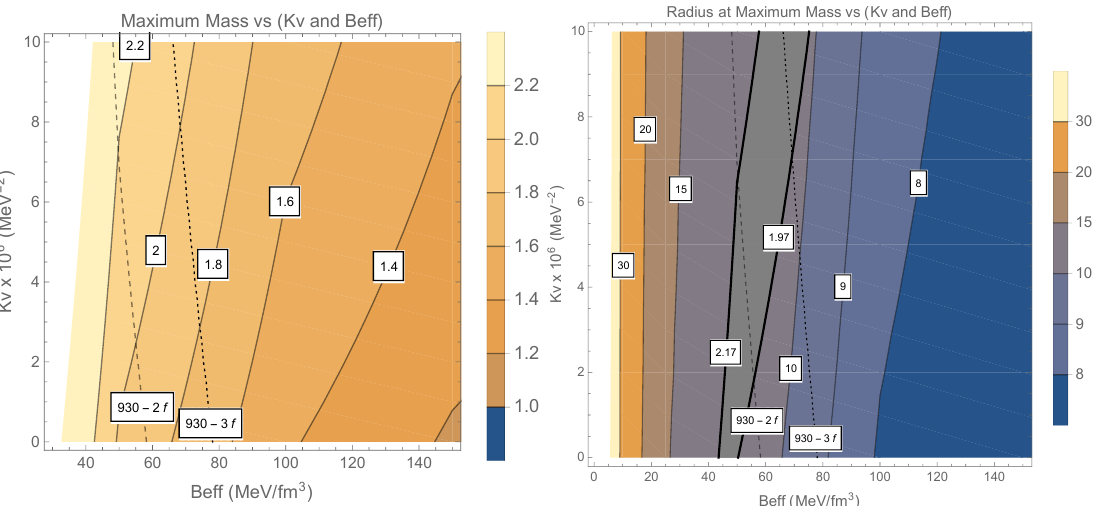
Figure 1. Contours of constant maximum mass ( left panel ) and of constant radius at maximum mass ( right panel ) in the vBag parameter model space. Also shown are the two-flavor and three-flavor lines of constant energy/baryon = 930 MeV (light dotted lines in both panels) and contours corresponding to values of maximum mass (right panel only) of two heavy neutron stars—J1614-2230 at 1.97 M (cid:12) from pulsar observations [8] and the neutron star merger event GW170817 at 2.17 M (cid:12) [23]. The apparent degeneracy of mass (or radius) in this parameter space is due to the fact that both parameters B eff and K v can be chosen independently to effectively soften or stiffen the equation of state beyond a desired baryon density that still admits stable strange